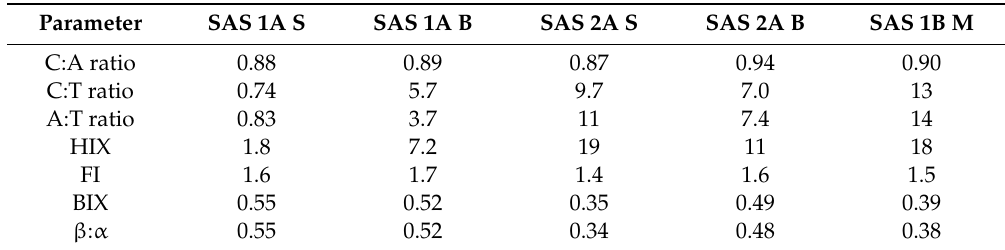
Table 3. Calculated ratios and indexes for acidified DOM samples from surface (S), middle (M), and bottom (B)